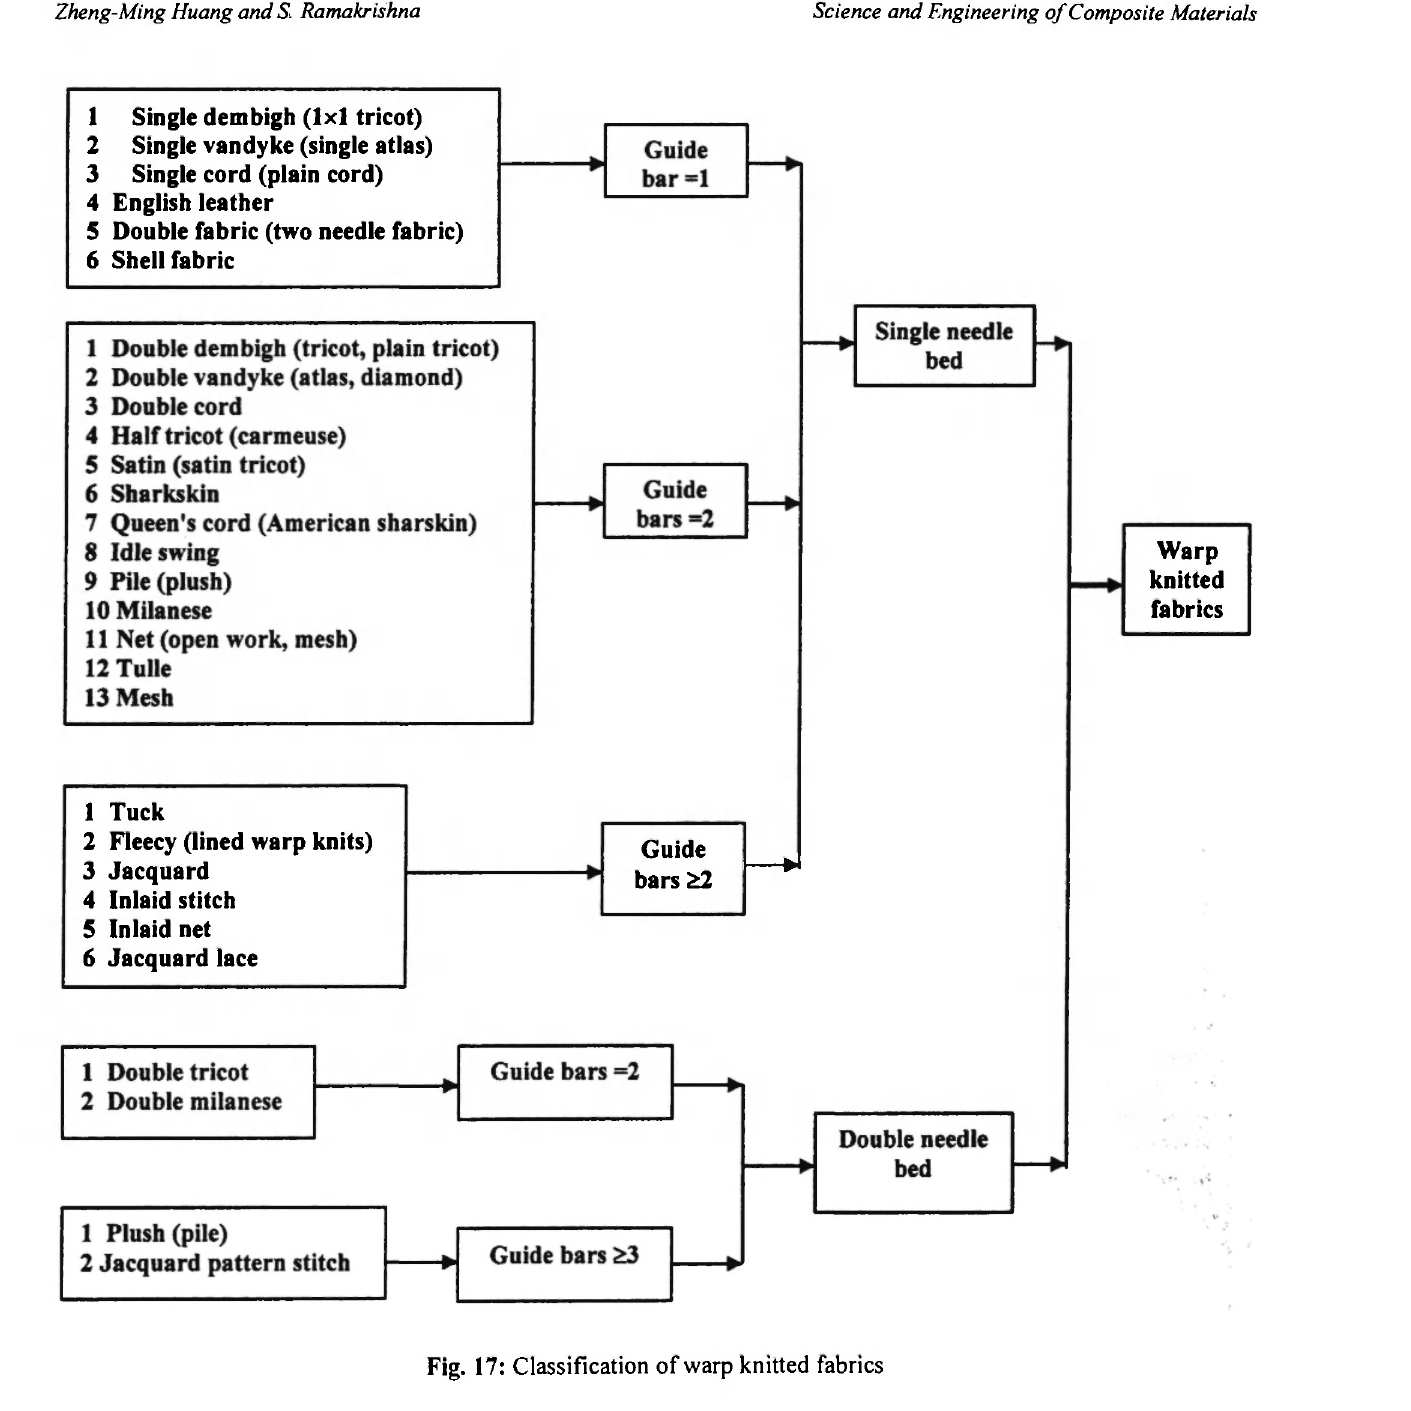
Fig. 17: Classification of warp knitted